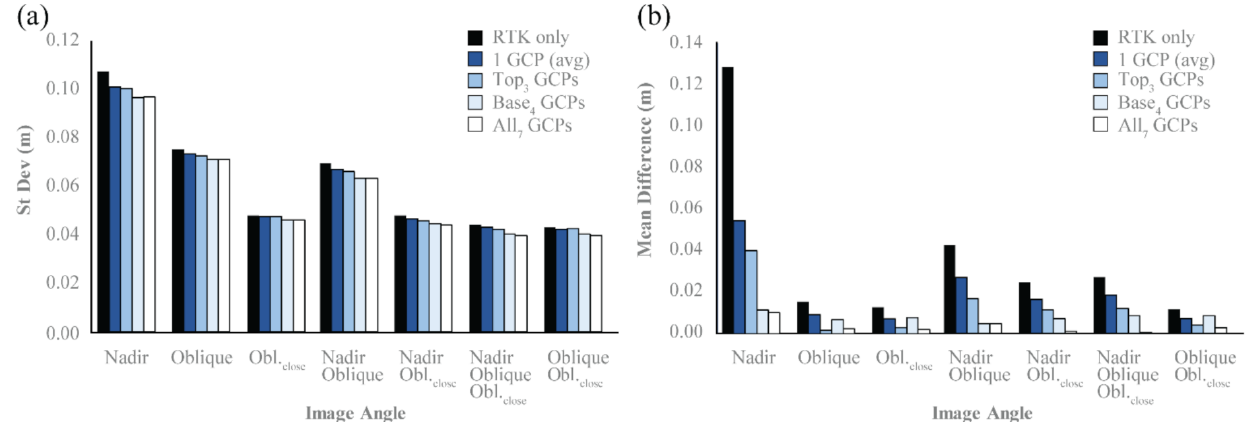
Figure 4. M3C2 error statistics grouped by imaging angle with subgroups based on georeferencing. ( a ) standard deviation of error; ( b ) mean error. ‘Obl.’ refers to